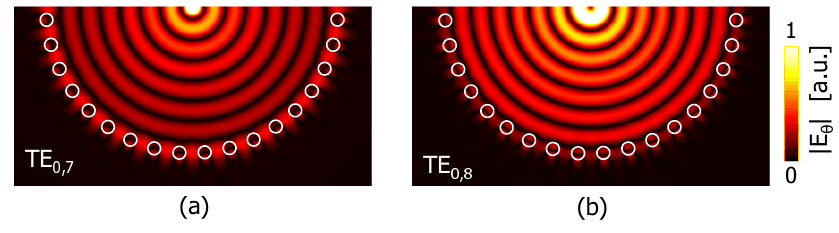
Figure 4. Field profiles of the TE modes. ( a ) TE corresponding